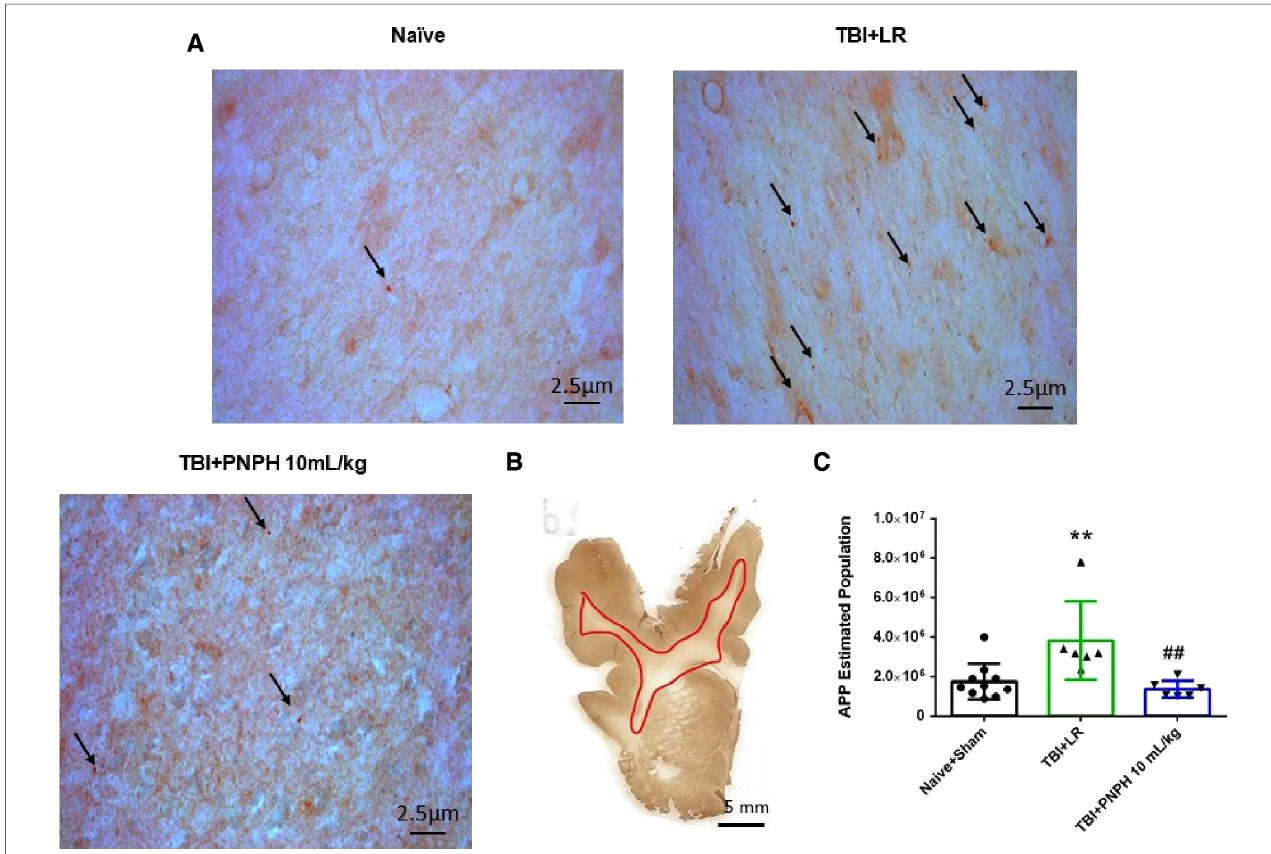
FIGURE 9 Effect of PNPH on APP expression after TBI without HS. ( A ) Representative images of APP immunostaining from naïve pig and pigs infused with 10 ml/kg LR or 10 ml/kg PNPH at 2 h after TBI. Arrows point to particles of APP accumulation. ( B ) The area of subcortical white used in the analysis is illustrated with the red trace. ( C ) The number of APP particles throughout subcortical white matter was estimated with the optical fractionator method of unbiased stereology and are plotted for the combined Naïve+Sham group ( n =10) and for TBI groups infused with 10 ml/kg LR ( n =6) and 10 ml/kg PNPH ( n =6). APP particles increased after TBI with LR infusion but not after PNPH infusion. Mean±SD and individual data for each pig are shown. ** P <0.01 vs. combined naïve and sham groups, ## P <0.01 vs. LR group determined by one-way ANOVA and the Holm-Sidak procedure for multiple